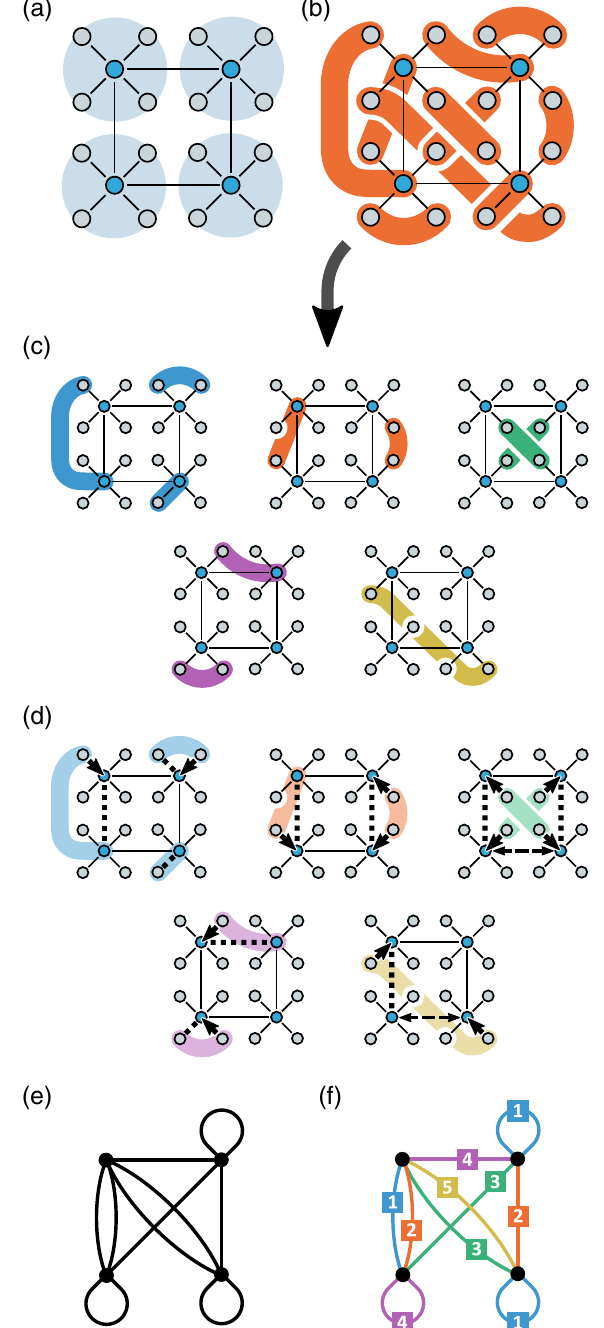
FIG. 5. (a) Example of a network with k ¼ 2 and h ¼ 4 hidden qubits per grid site. The circles indicate the grid groups of qubits. (b) One instance of a grouping of the 20 qubits into 10 pairs which aretobecoupledbytwo-qubitgates.(c)Decompositionofthepairs into groups G 1 ; … ; G 5 such that for each G no two qubit pairs i belonging to it share a grid group. (d) Implementation of the gates between the qubit pairs in each group as a combination of swaps between hidden and control qubits (solid arrows), swaps between control qubits (dashed arrows) and entangling gates (dotted lines). (e) Multigraph corresponding to the qubit pairing from (b) and its edge coloring (f) which results in the decomposition from